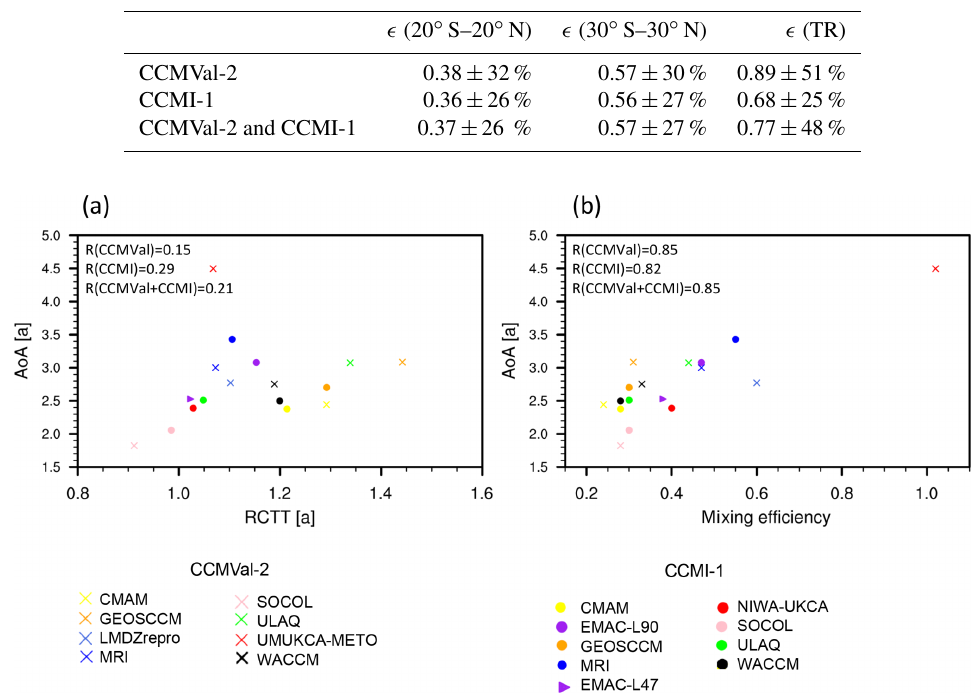
Figure 6. Scatterplot showing the relationship between mean tropical (20 ◦ N–20 ◦ S) AoA and (a) mean tropical RCTT and (b) mixing efficiency. CCMVal-2 models are represented by cross symbols and CCMI-1 models by filled dots, except EMAC-L47, which is represented by a triangle. Values are all given at 10km above the tropical tropopause. The corresponding correlation coefficients R are given within the individual